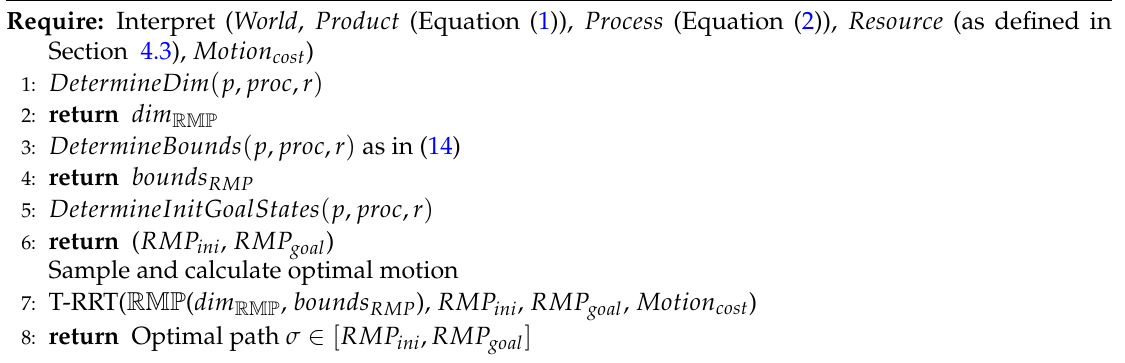
Algorithm 2 Automatic interpretation and computation of robotic milling optimizing stiffness using T-RRT.